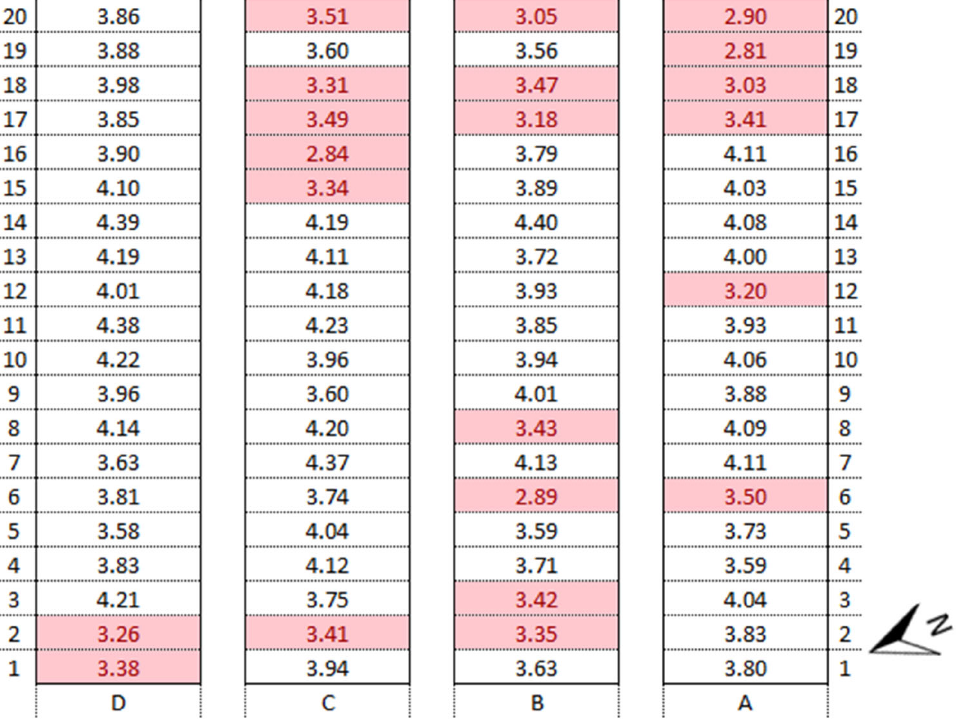
Figure 18. Division of plots according to the value of the lower quartile of yields (Q 25 = 3.51 t/ha) to LOW ‐ YIELD AREA (yield ≤ Q 25 ; color ‐ coded plots) and HIGH ‐ YIELD AREA (yield > Q 25 ).